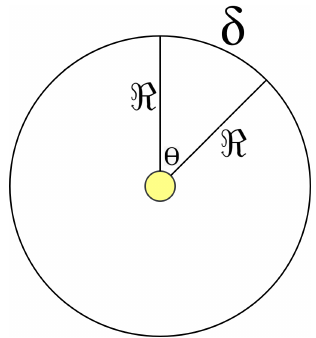
Figure 6. In any circle, the relation between the length of Arc ‘ δ ’, the radius ‘ (cid:60) ’, and the angle ‘ Θ ’, measured in radian system, is δ = Θ × (cid:60) .